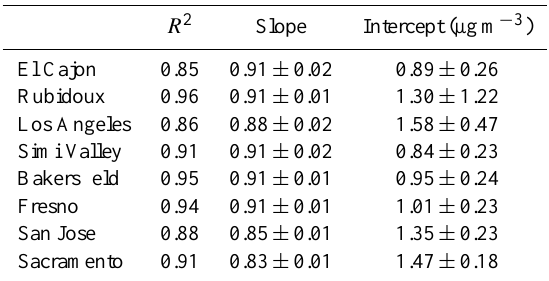
Table 2. Summary of the marker species for identified PM 2 . 5 Table 3. Summary statistics of the linear correlations between daily sources, resolved by the PMF model. resolved measured ambient PM 2 . 5 and estimated PM 2 . 5 mass con- centrations obtained from the PMF model. Errors correspond to 1 standard Marker species